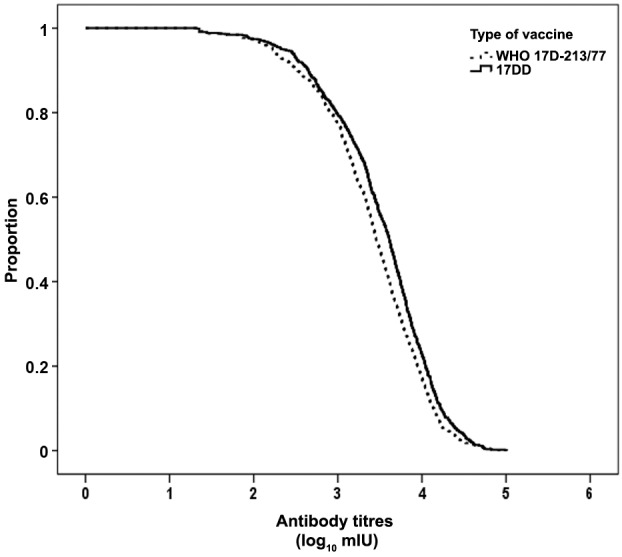
: reverse cumulative distribution of the post-vaccination antibody titres
(log10 mIU/mL of serum) against yellow fever according to the type of vaccine
(p = 0.0001; log-rank test).